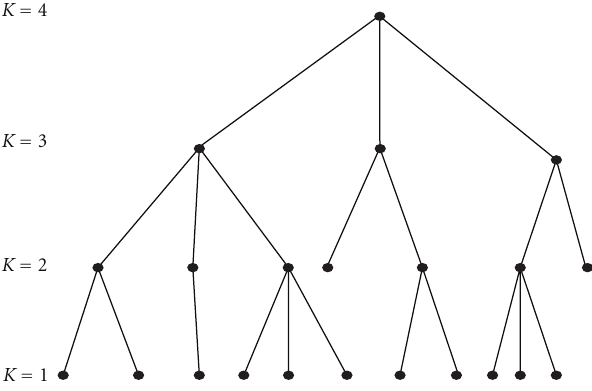
Figure 1: The possible searching paths in a tree for P = 3 and 4—